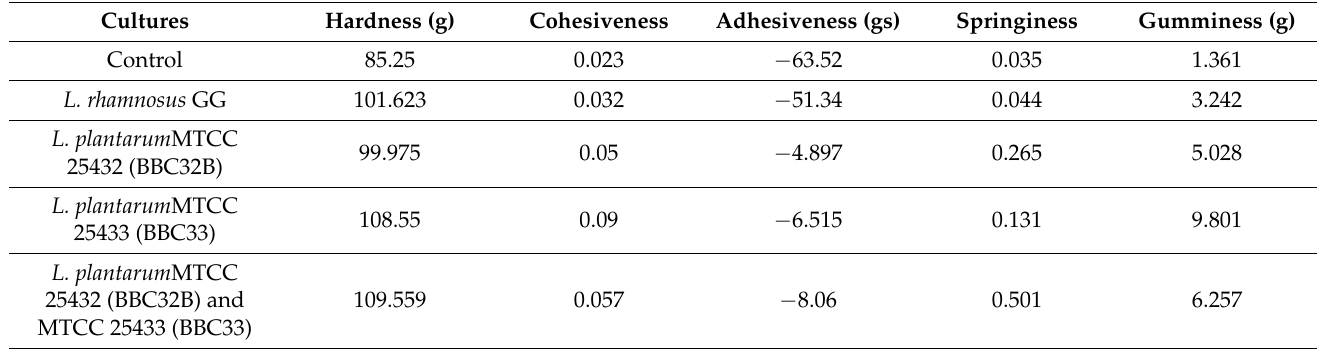
Table 3. Textural analysis characteristics; Texture analysis parameters (Hardness, cohesiveness, adhesiveness and gummi- ness) of the soycurd samples fermented with different probiotic strains and combination, showed a significant correlation of the pure cultures of L. rhamnosus GG, L. plantarum MTCC 25432 (BBC32B), L. plantarum MTCC 25433 (BBC33) and combination of L. plantarum MTCC 25432 (BBC32B) and MTCC 25433 which indicated the probiotic acceptability of these strains. The values are expressed as mean ± SEM of three independent experiments with SD and significant difference ( p <